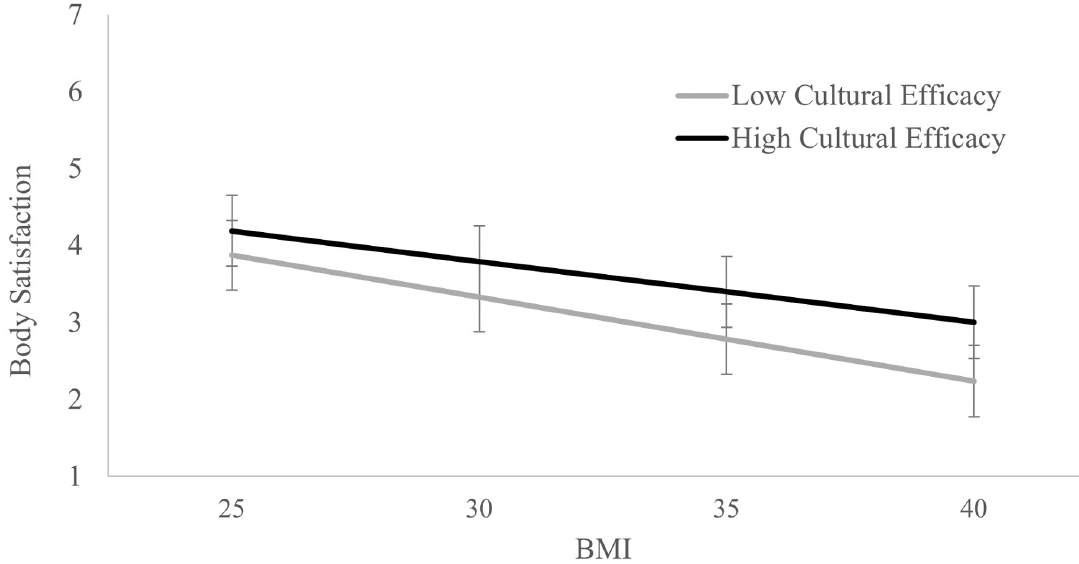
Fig 1. Estimated levels of body satisfaction for high (+1 SD) and low (-1 SD) levels of cultural efficacy and identity engagement and different BMIs. Error bars represent the 95% confidence intervals.